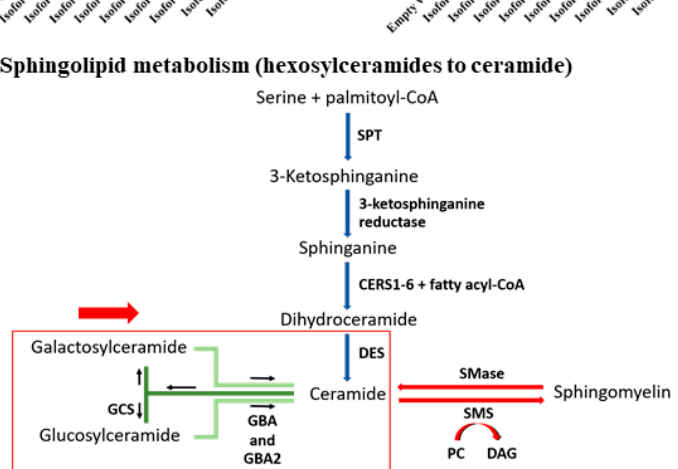
Figure5. E ff ectofGBA2isoformsonceramide / hexosylceramidepeakintensityratiosofspecificceramide Figure 5. Effect of GBA2 isoforms on ceramide / hexosylceramide peak intensity ratios of specific species. ( A ) Ceramide / hexosylceramide (34:1, 40:1, 42:1, and 42:2), ( B ) sphingolyelin / hexosylceramide ceramide species . ( A ) Ceramide/hexosylceramide (34:1, 40:1, 42:1, and 42:2), ( B ) (40:1, 42:1, and 42:2) and ceramide / hexosylceramide ratios for 34:1, 40:1, 42:1, and 42:2 are sphingolyelin / hexosylceramide (40 : 1, 42 : 1, and 42 : 2) and ceramide / hexosylceramide ratios for 34 : 1,